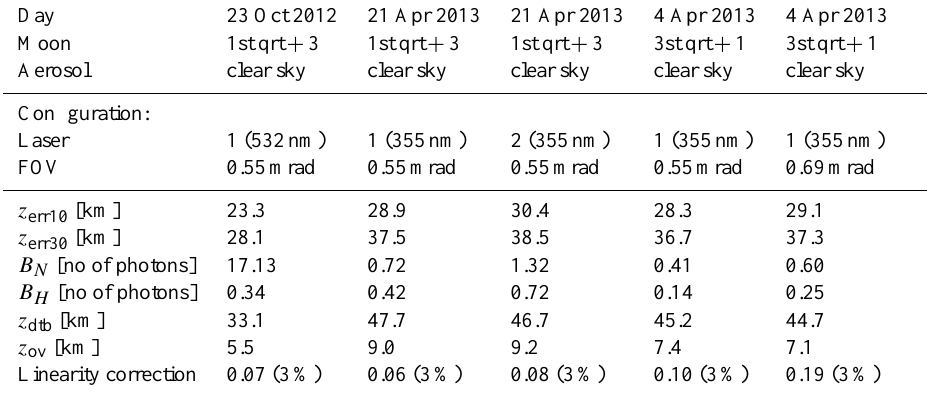
Table 3. Lidar performance parameters of the nitrogen Raman channel of the MAIDO-H 2 O lidar for different tested configurations. A tem- poral integration of 30min has been applied to the raw lidar data and no vertical integration. The percentage errors of the linearity correction values (last row) are given in